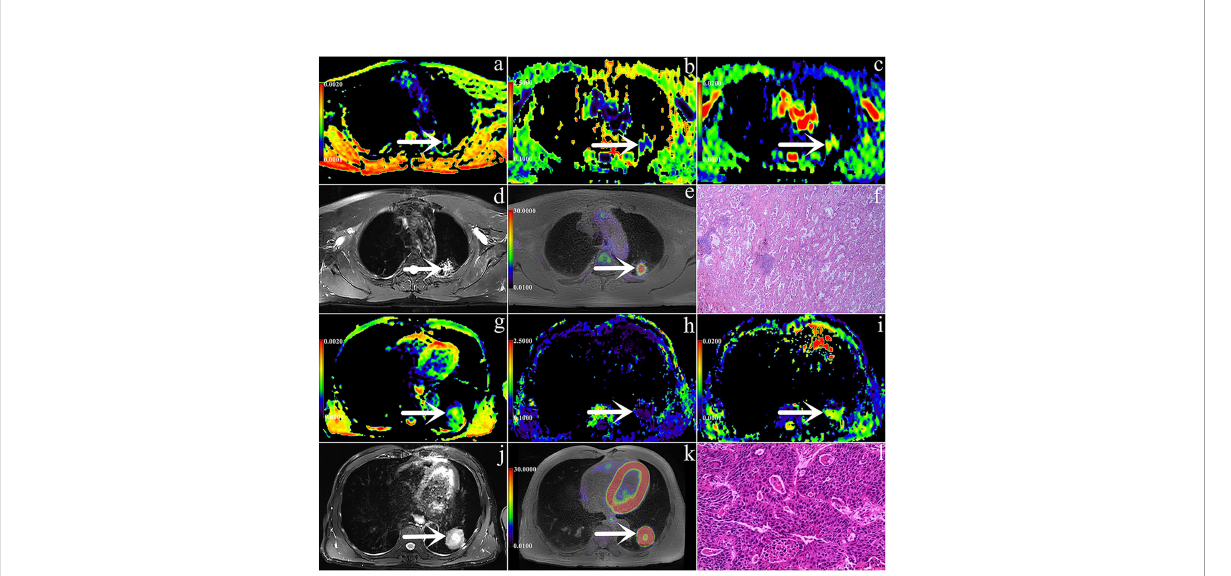
FIGURE 2 (A – L) are PET/MR images and pathological images. (A – F) Male, 56 years, with staging IIB, AC (shown by white arrows), Ki-67 is 30%, ADC = 1.505 × 10 -3 mm 2 /s, MK = 0.652, MD = 2.768 × 10 -3 mm 2 /s, SUVmax = 5.08 g/cm 3 , MTV = 2.44 cm 3 , TLG = 7.28 g; g-l Male, 58 years, with staging IIIB, SCC(shown by white arrows), Ki-67 is 70%, ADC = 1.068 × 10 -3 mm 2 /s, MK = 0.291, MD = 2.622 × 10 -3 mm 2 /s, SUVmax =11.84 g/ cm 3 , MTV = 12.248 cm 3 , TLG = 83.408 g. In these images, a/g are ADC pseudo-colored maps, b/h are MK pseudo-colored maps, c/i are MD pseudo-colored maps, d/j are T2WI images, e/k are PET images and f/l are pathological images (magni fi cation=100).